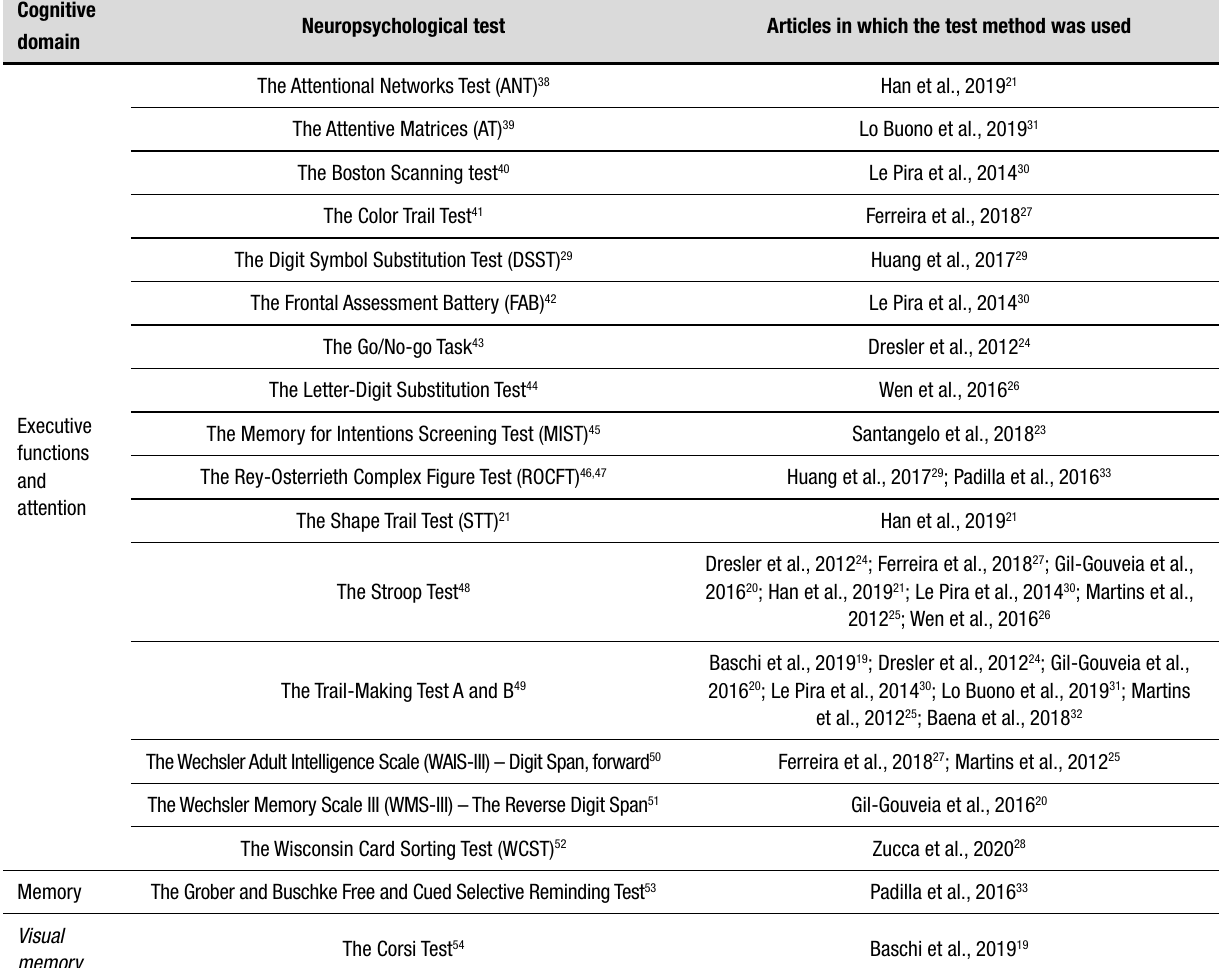
Table 2. Neuropsychological test methods used to assess cognition according to cognitive domain.